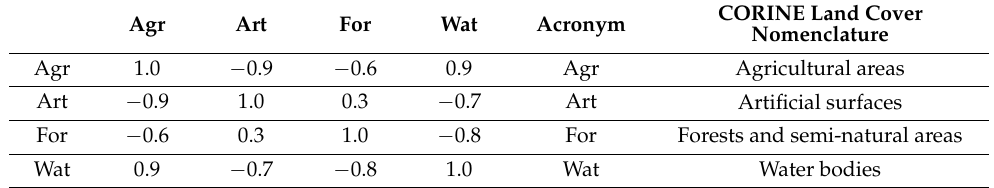
Table 9. Spearman’s rank correlation coefficient in the Madeira Archipelago.